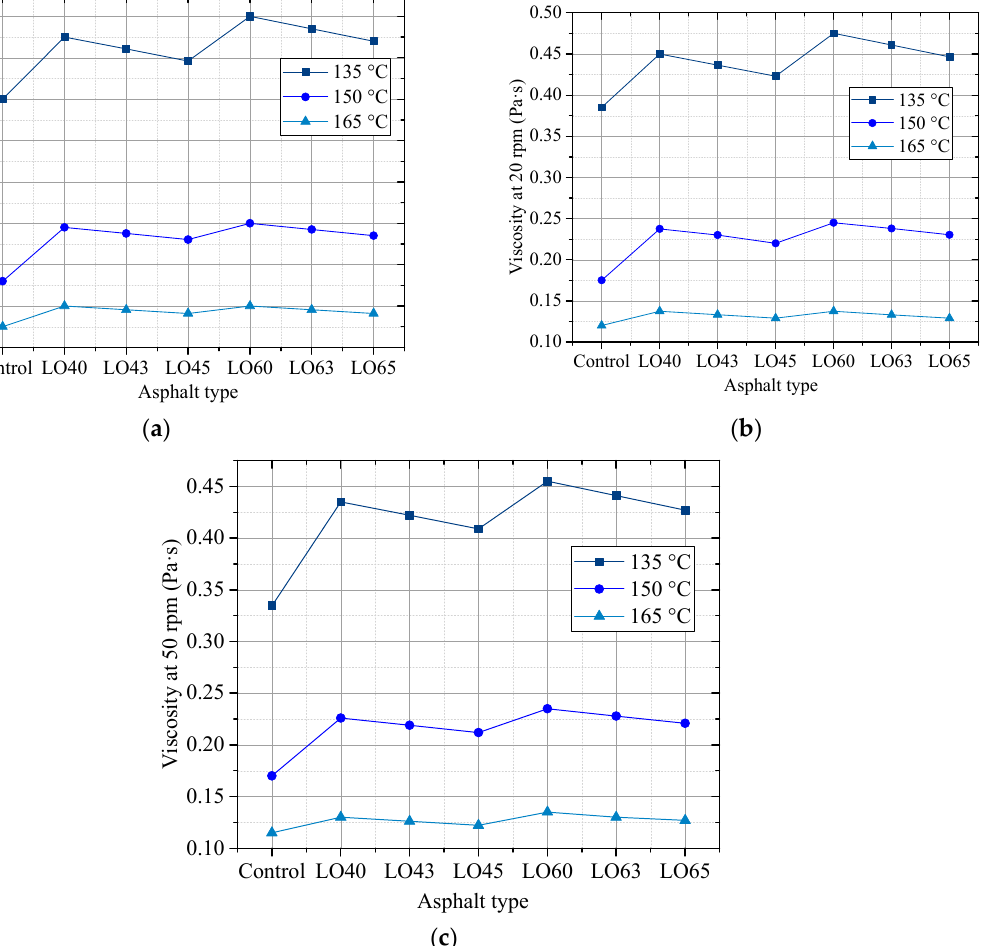
Figure 2. The viscosity of different asphalt types at different rotational speeds. ( a ) 10 rpm; ( b ) 20 rpm; ( c ) 50 rpm.